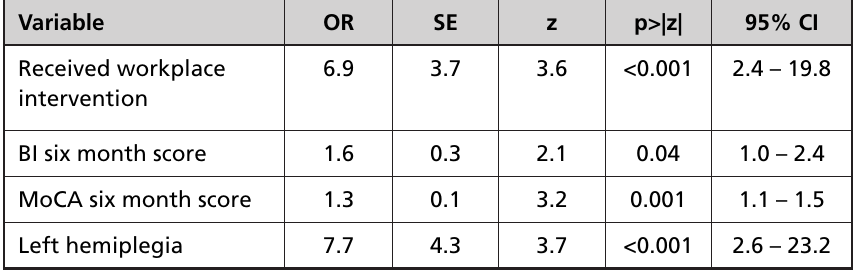
Table 4: Factors that had an influence on RTW after stroke: multivariate analysis